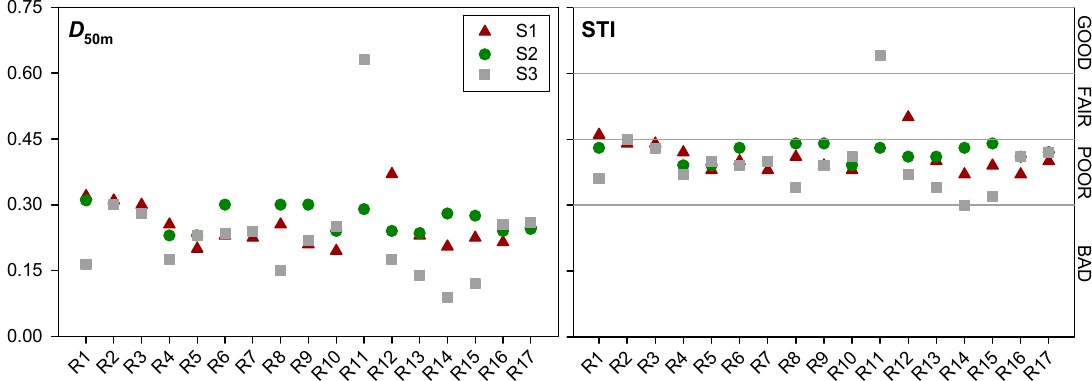
Figure 12. Simulated mappings of the D 50 at 1 kHz (upper row) and STI (lower row) obtained for the different source positions. York Minster’s Chapter House in its current state.